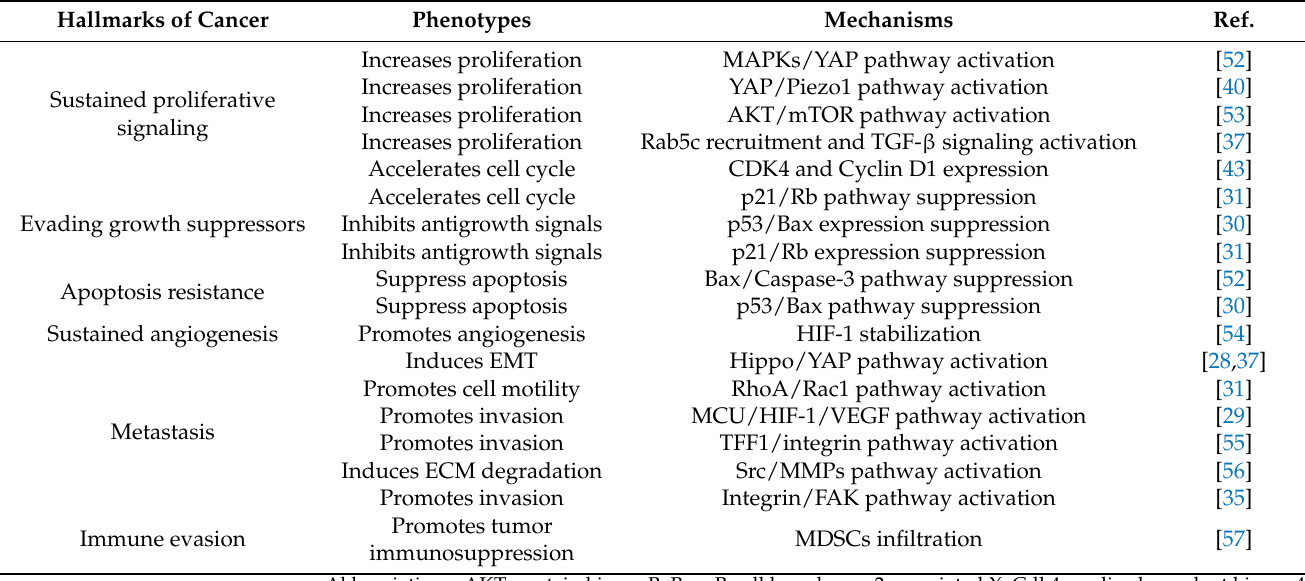
Table 2. Piezo1 regulation on hallmarks of